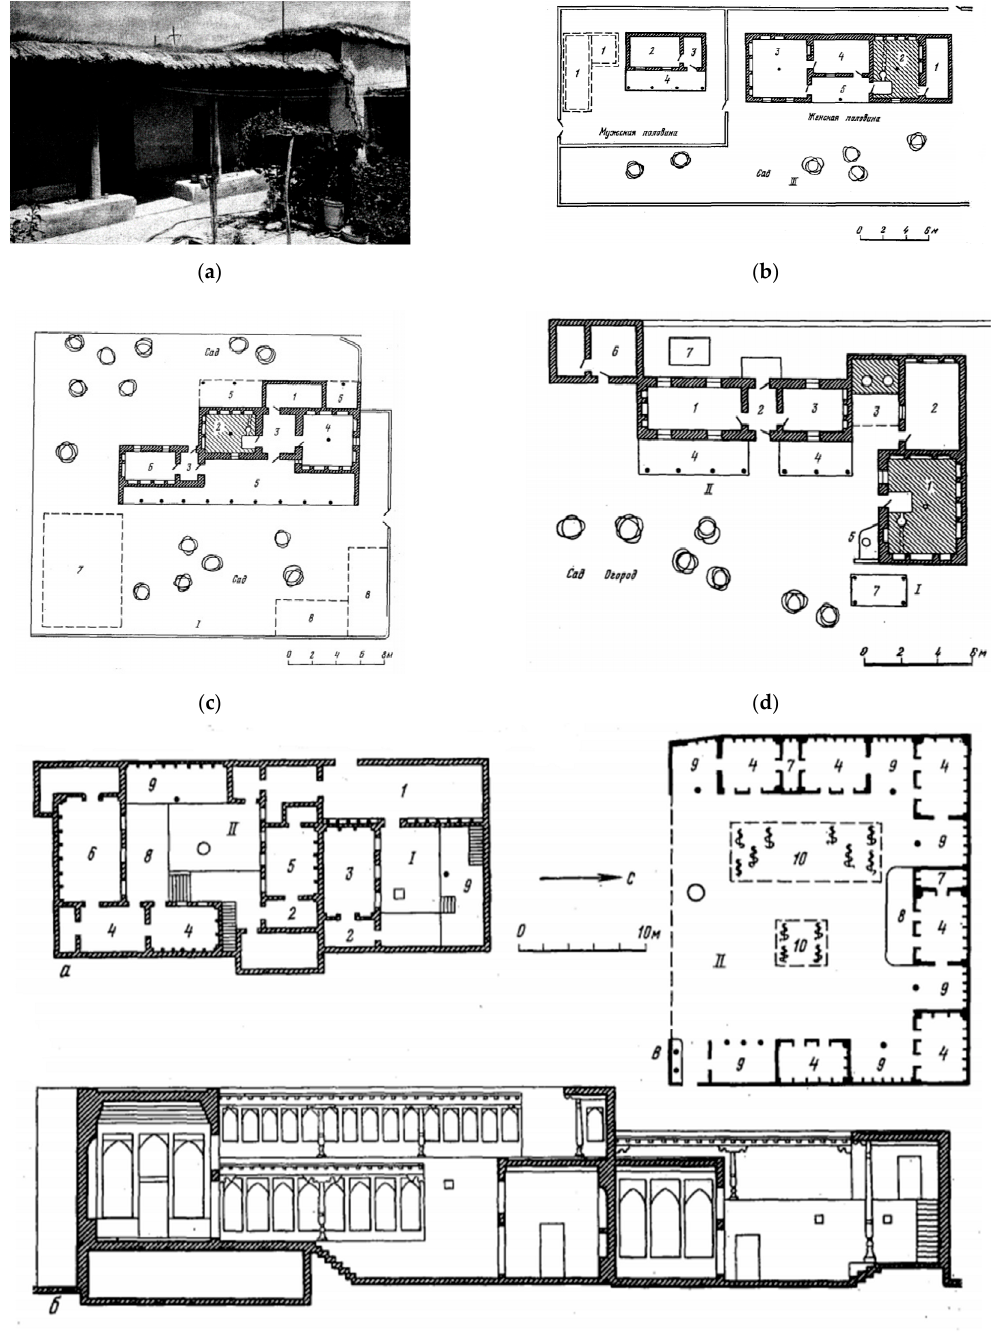
Figure 2. The traditional form of a rural house in the territory of Southern Kazakhstan is: ( a ) A house of traditional layout with an aivan, built in the village of Karnak in the 1930s. ( b ) The layout of traditional dwellings and estates of the late 19th to early 20th century for the wealthy strata of the population. ( c ) The plan of the judge’s house and estate (treasury), built at the end of the 19th century. V. S. Karnak (s—z Atabaevsky) Turkestan district of the Shymkent region. ( d ) The plan of a house built during the Soviet period in the village of Ikan (Eski Ikan), the Turkestan district of the Shymkent region. Source: A. N. Zhilina, Traditional settlements and housing of the Uzbeks of Southern Kazakhstan, E.E. Nerazik and A.N. Zhilina “Housing of the peoples of Central Asia and Kazakhstan”, Moscow: Nauka, 1982. ( e ) Perimeter yard construction: a, b—house in Bukhara (plan and section), c—house in Kitab (plan). (https://www.academia.edu (accessed on 8 July 2021)).